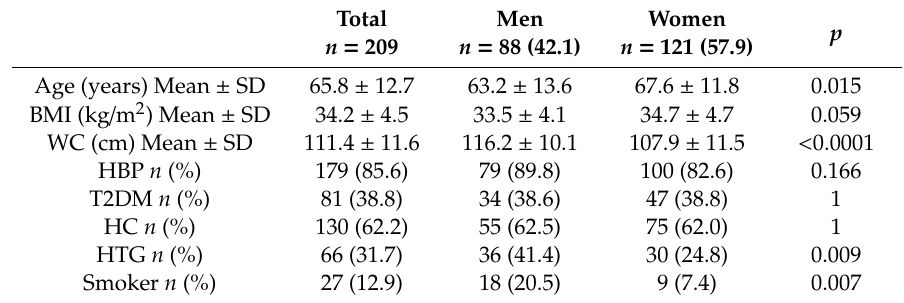
Table 1. Sociodemographic, clinical and laboratory characteristics of patients a ff ected by obesity in primary care (current data).